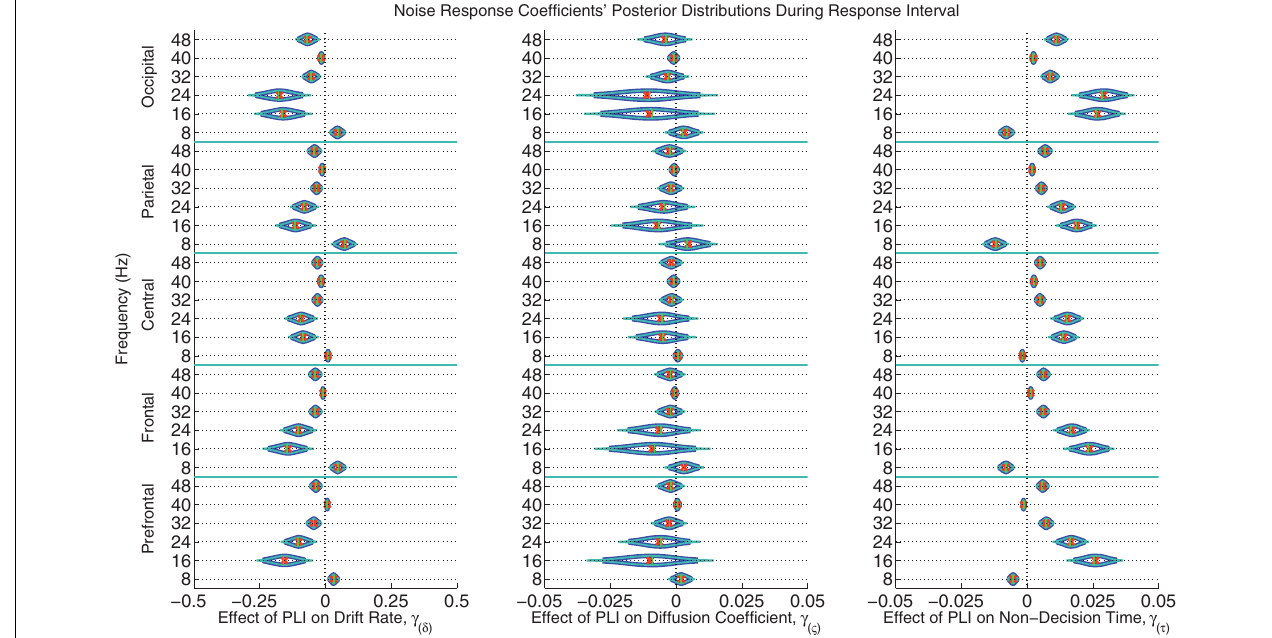
FIGURE 7 | The marginal posterior distributions of the noise PLI coefficients. I.e., the effects of noise suppression, as measured by a steady-state phase-locking index (PLI), on the evidence accumulation rate (drift rate; in evidence units per second), variance in the evidence accumulation process (the diffusion coefficient; in evidence units per second), and non-decision time (in seconds) during the response interval. Dark blue lines indicate 95% credible intervals, smaller teal lines indicate 99% credible intervals, horizontal green lines indicate posterior medians, and the orange exes indicate posterior means. At noise harmonic frequencies (16, 24, 32, and 48Hz) during the response interval, those subjects who suppressed noise had faster evidence accumulation rates; this effect was